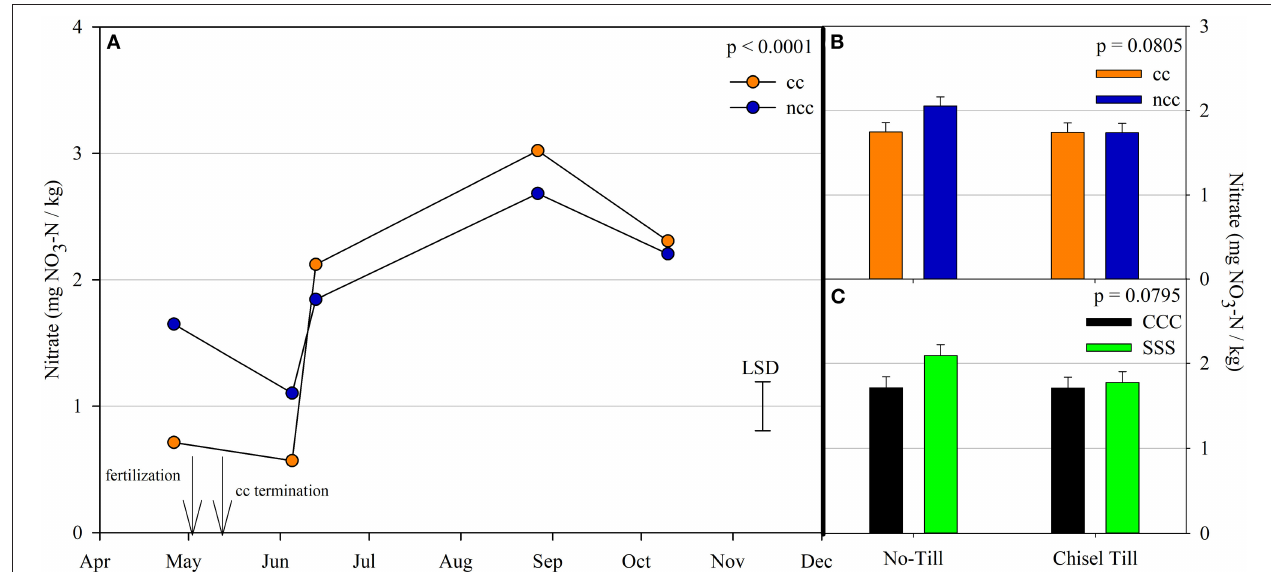
figure. Mean values that fall beyond the distance of the LSD are significant at α = 0.10. (B) mean soil nitrate values (mg NO 3 -N kg − 1 ) separated by cover crop [CC, cover crop (orange); NCC, no cover crop (blue)] and tillage [NT, no-till; T, chisel tillage]. Error bars above each main bar represent standard errors of the mean PC scores. Differences are significant at α = 0.10. (C) mean soil nitrate values (mg NO 3 -N kg − 1 ) separated by crop rotation [CCC, continuous corn (black); SSS, continuous soybean (green)] and tillage [NT, no-till; T, chisel tillage]. Error bars above each main bar represent standard errors of the mean. Differences are significant at α =